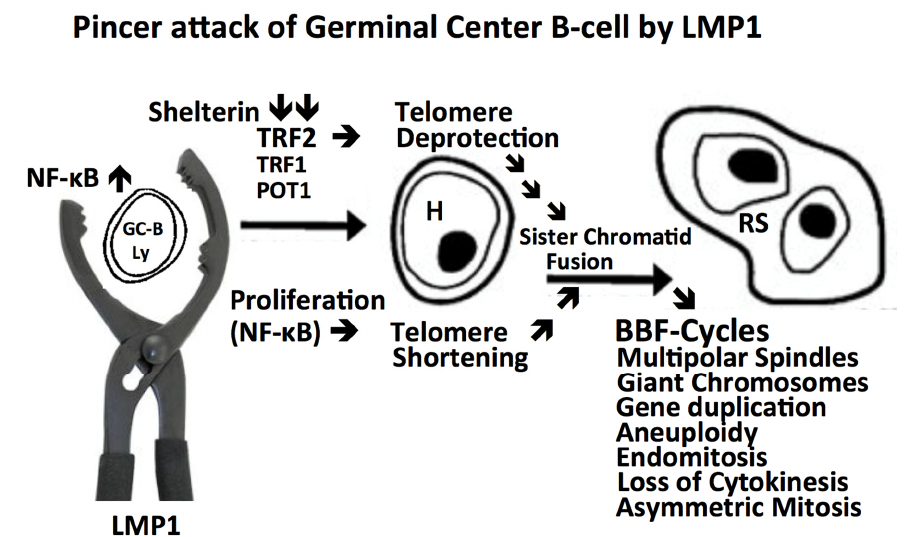
Figure 1. Continuous transformation from a GC B-lymphocyte into an H-cell and terminal RS-cell. A “crippled” GC B-lymphocyte [24] or an EBV + memory B-lymphocyte [25] re-entering GC reaction undergoes LMP1 oncoprotein induced transformation targeting the telomere-shelterin complex through a “pincer attack”. NF-kB driven mitosis [37] leading to telomere shortening and TRF2 down-regulation [60,68] resulting in telomere de-protection, both in concert generate short de-protected telomeres, prone to undergo sister chromatid fusion as the origin of repeated BBF-cycles, resulting first in H-cells [60], and, after several subsequent mitotic cycles, in the end-stage multi-faceted, often telomere poor RS-cells [60–62,67–69] The telomere-shelterin complex appears to emerge as a logical candidate for a common pathogenic denominator of both EBV-positive and EBV-negative cHL because LMP1 alone induces multi-nuclearity also in the 293 embryonic kidney cell line [38] and the myelomonocytic HD-MyZ cell line